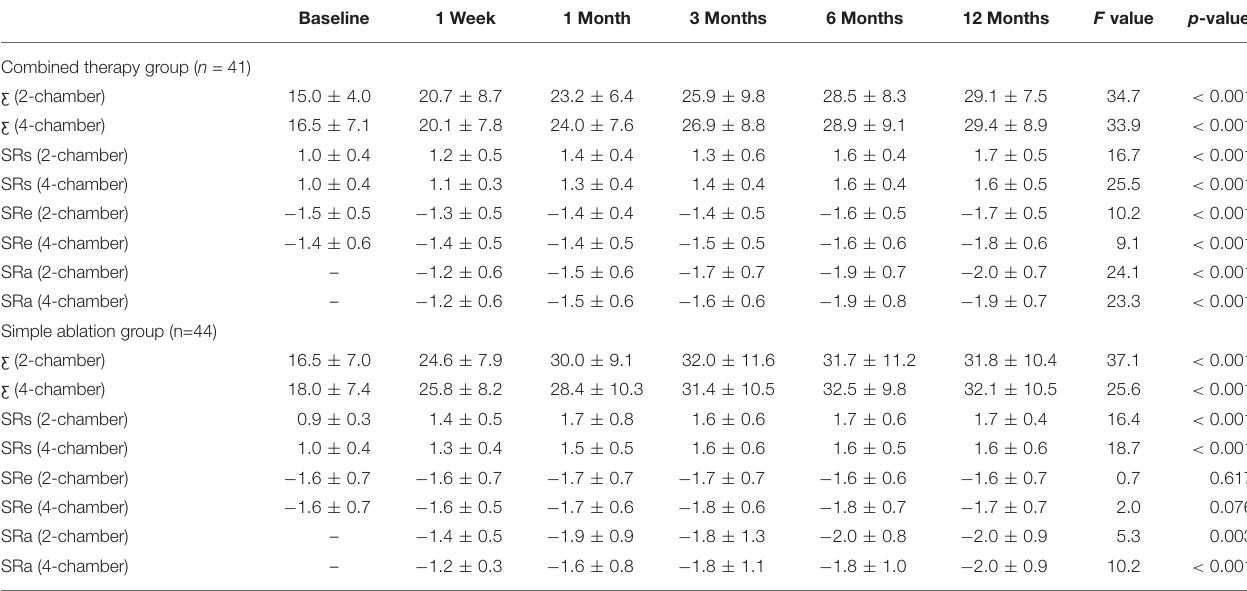
TABLE 3 | Evolution of LA function after the LAAC combined with CA and simple CA group assessed strain indices. Baseline 1 Week 1